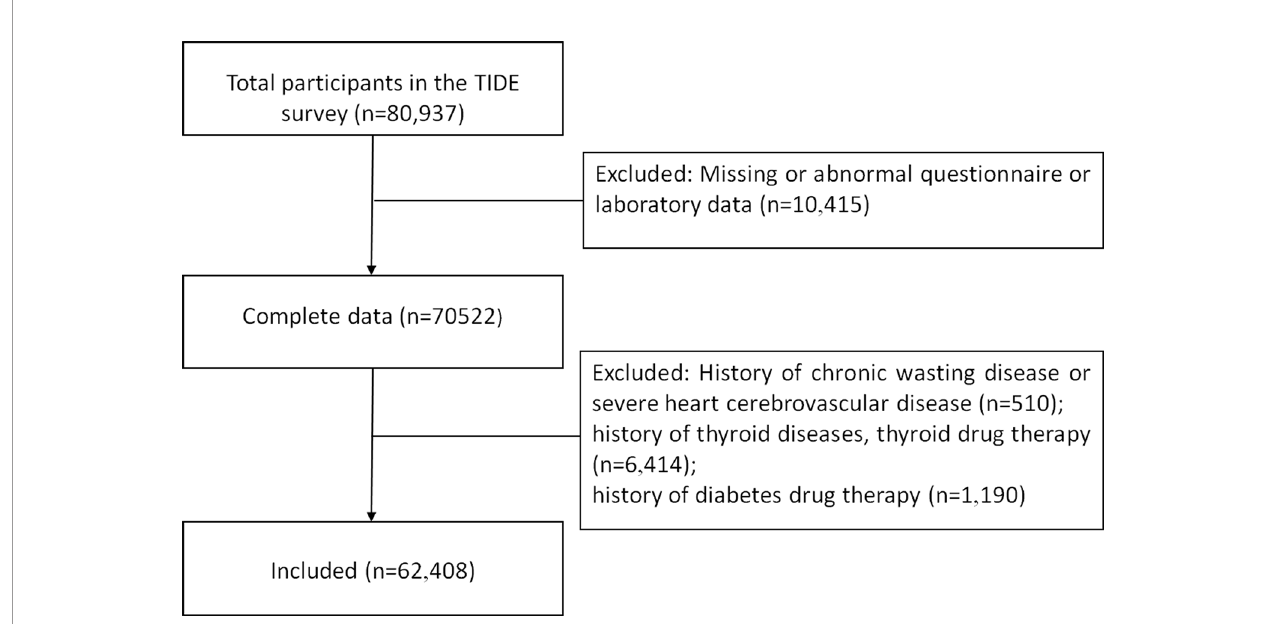
FIGURE 1 | Screening fl ow